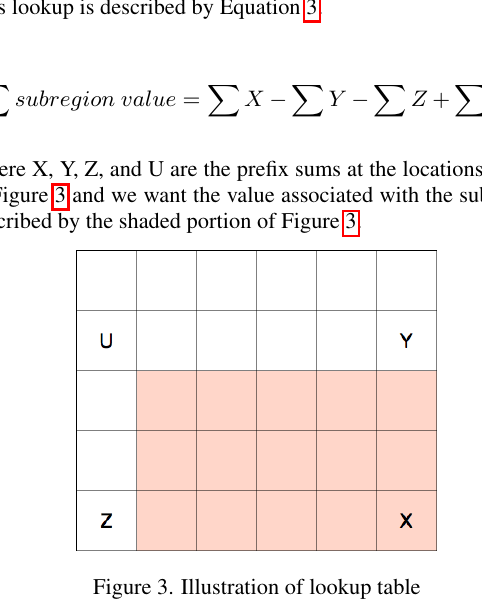
Algorithm 1 : High Level View Of Scan (Nguyen, 2007)